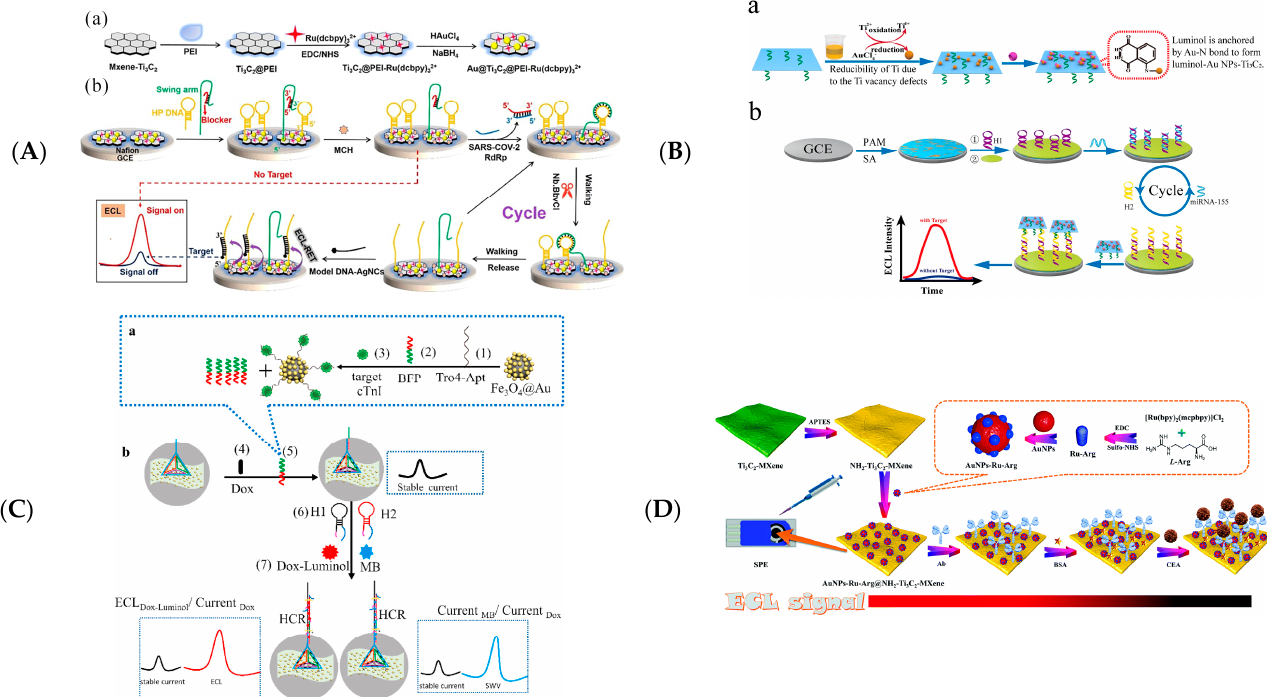
Figure 11. ( A ) Schematic diagram of the preparation of Au@Ti 3 C 2 @PEI-Ru(dcbpy) 32+ nanocom- posites ( a ); Combined unilateral DNA walker amplification strategy based on nanocomposites